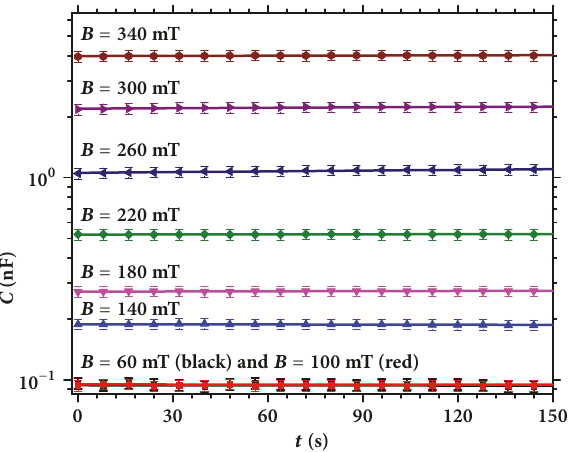
Figure 7: Electrical capacitance 𝐶 of hMRE as a function of time 𝑡 for fixed values of magnetic flux densities 𝐵 . Dots, experimental data; continuous lines. linear